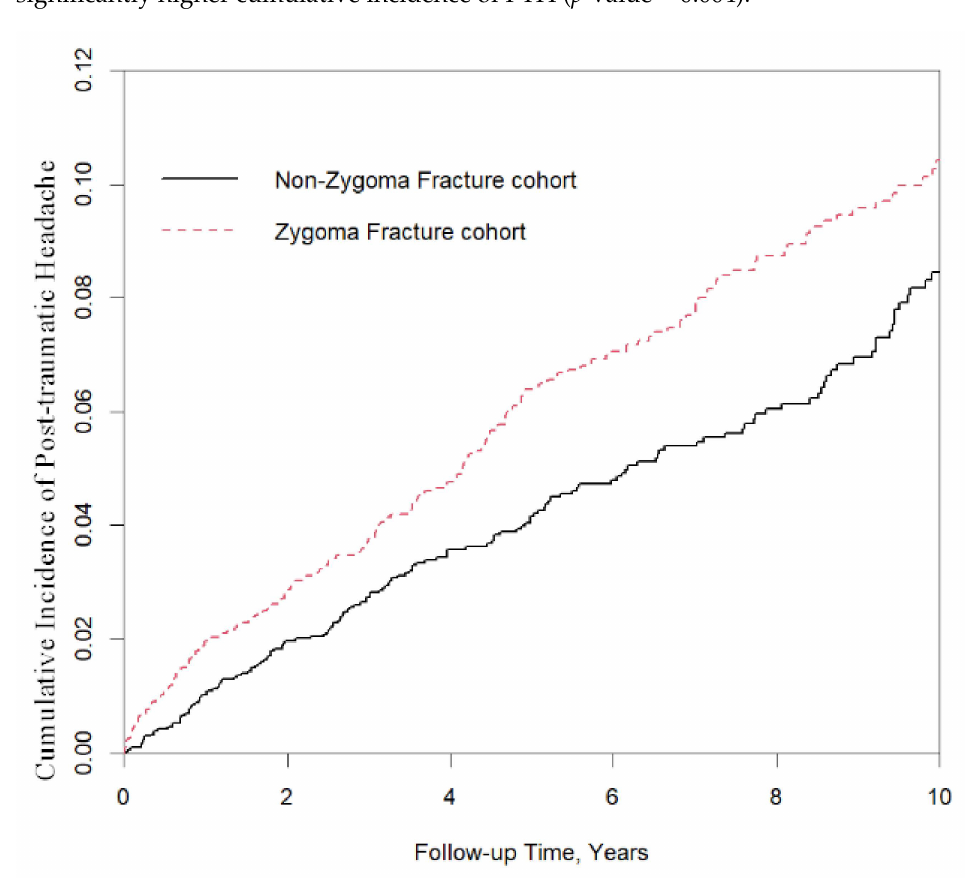
Figure 1. The zygoma fracture cohort had a significantly higher cumulative incidence of post- traumatic headache than the non-fracture group (log-rank test; p =